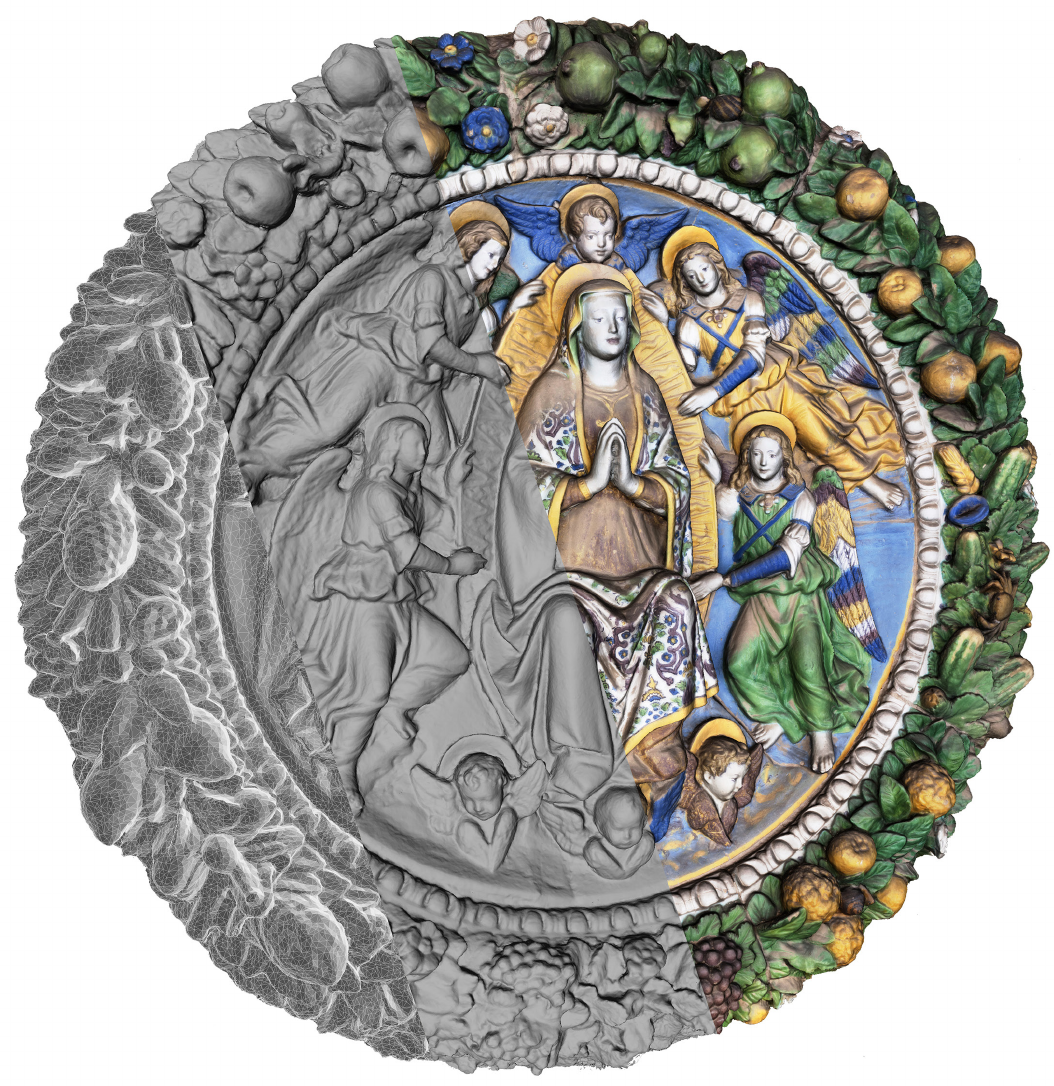
Figure 11. A sub-project mesh model, in wireframe, shaded and textured